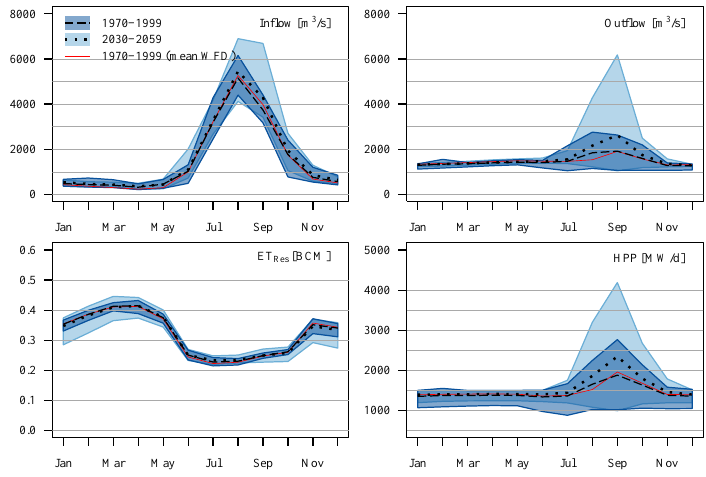
Figure 10. Range and mean of projected changes of inflows, outflows, ET Res , and HPP using the model ensemble; RCP 8.5 (2030–2059), hpp_1500MW_01a scenario.